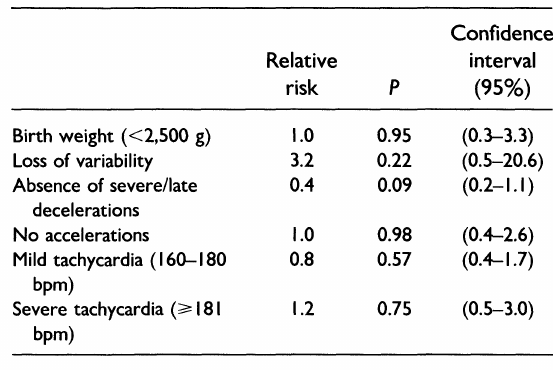
TABLE 3. Multiple logistic regression of variables with a Ua pH